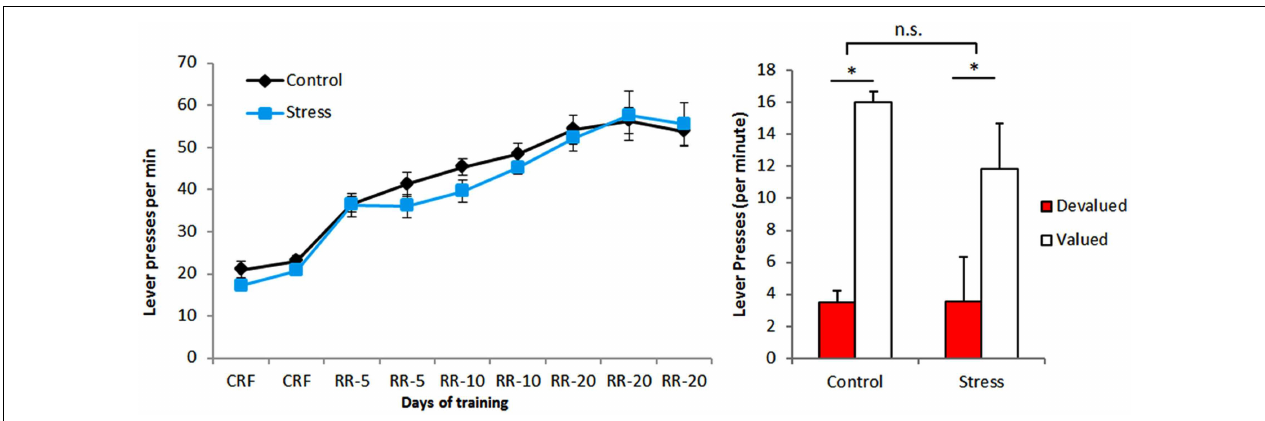
FIGURE 2 | Instrumental conditioning. Both experimental groups acquired the lever pressing task and were able to correctly distinguish devalued from valued levers.* p < 0.05.